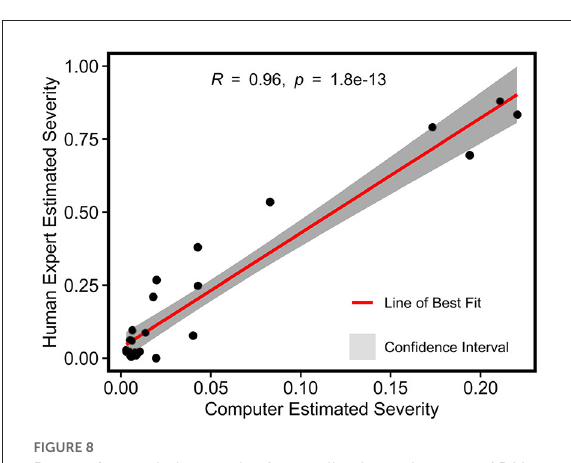
FIGURE8 Pearson’s correlation result of normalized severity rates of DM fungicide efficacy test calculated using the imaging-based pipeline and human field